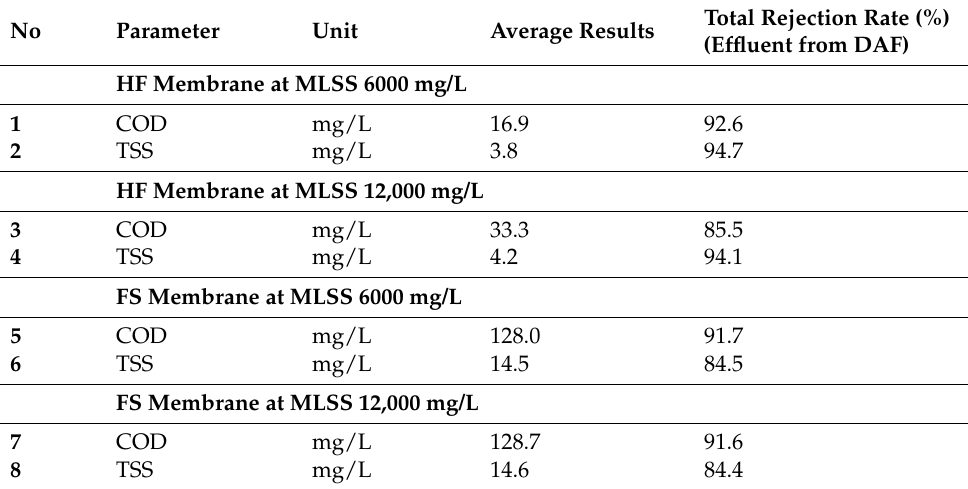
Table 6. Sample characteristics of the effluent in the MBR